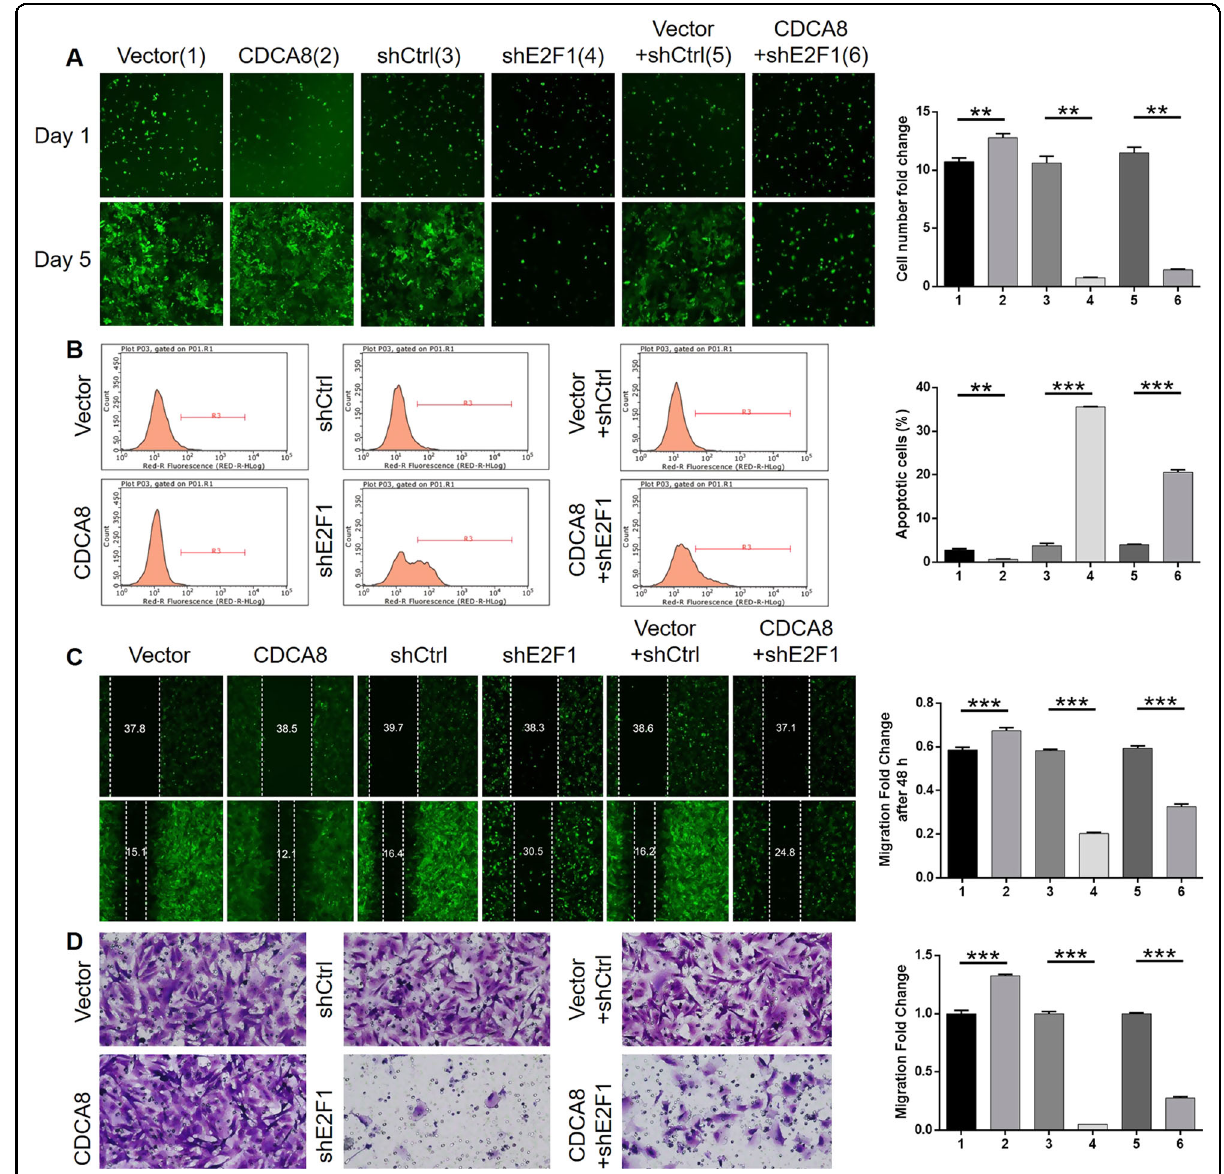
Fig. 5 CDCA8/E2F1 axis regulates glioma progression in vitro and in vivo. A Celigo cell count assay of overexpressed CDCA8, E2F1 knockdown, or simultaneous CDCA8 overexpression and E2F1 knockdown was used to detect proliferation of U251 cells. B The effects of CDCA8/E2F1 on U251 cell apoptosis were assessed by fl ow cytometry. C , D The wound-healing ( C ) and Transwell ( D ) assays of CDCA8/E2F1 were used to reveal their regulatory effects on U251 cell migration. The experiments were repeated three times independently, and the bars represent SD. ** P < 0.01, *** P <